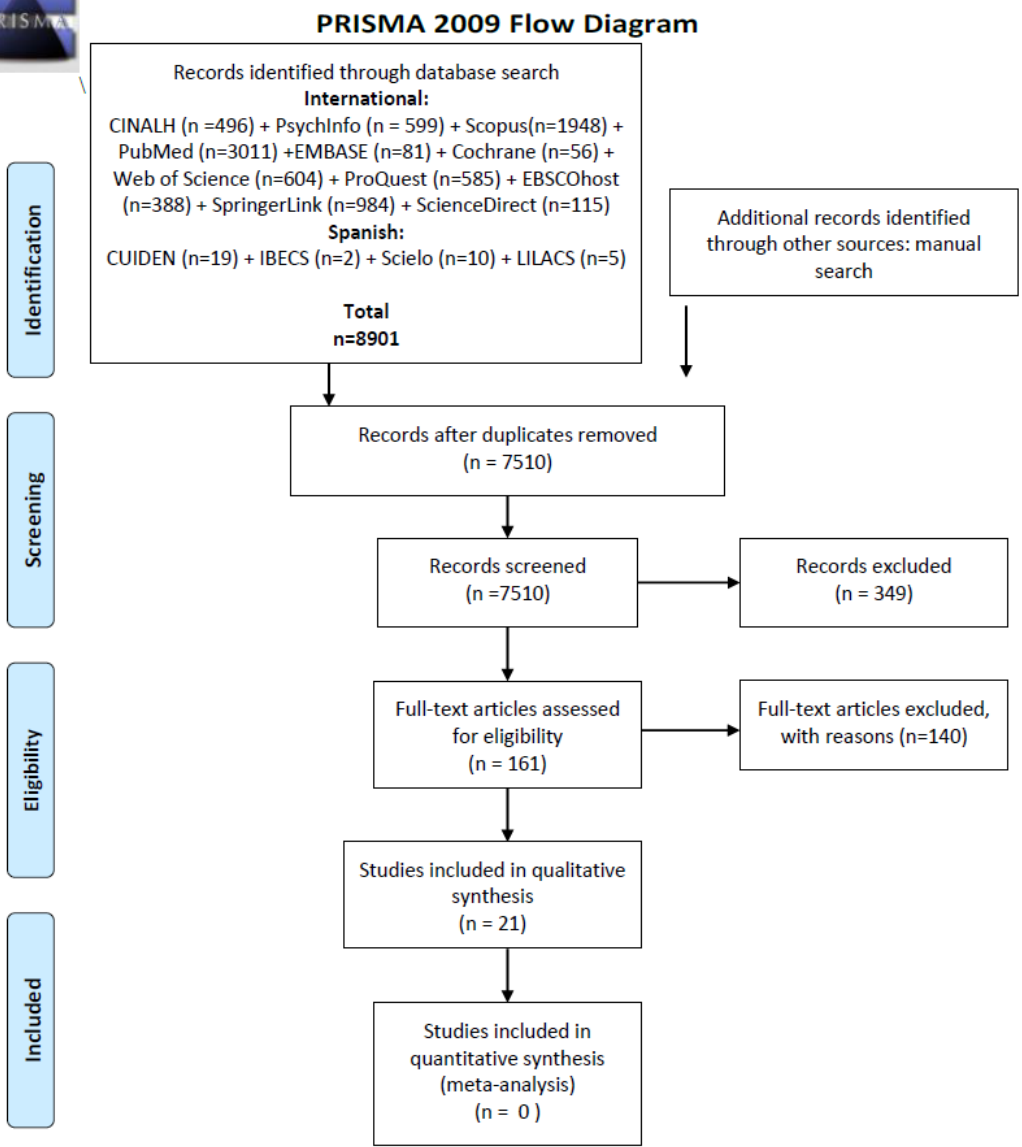
Figure 1. PRISMA 2009 Flow Diagram. From: Moher, D.; Liberati, A.; Tetzlaff, J.; Altman, D.G. The